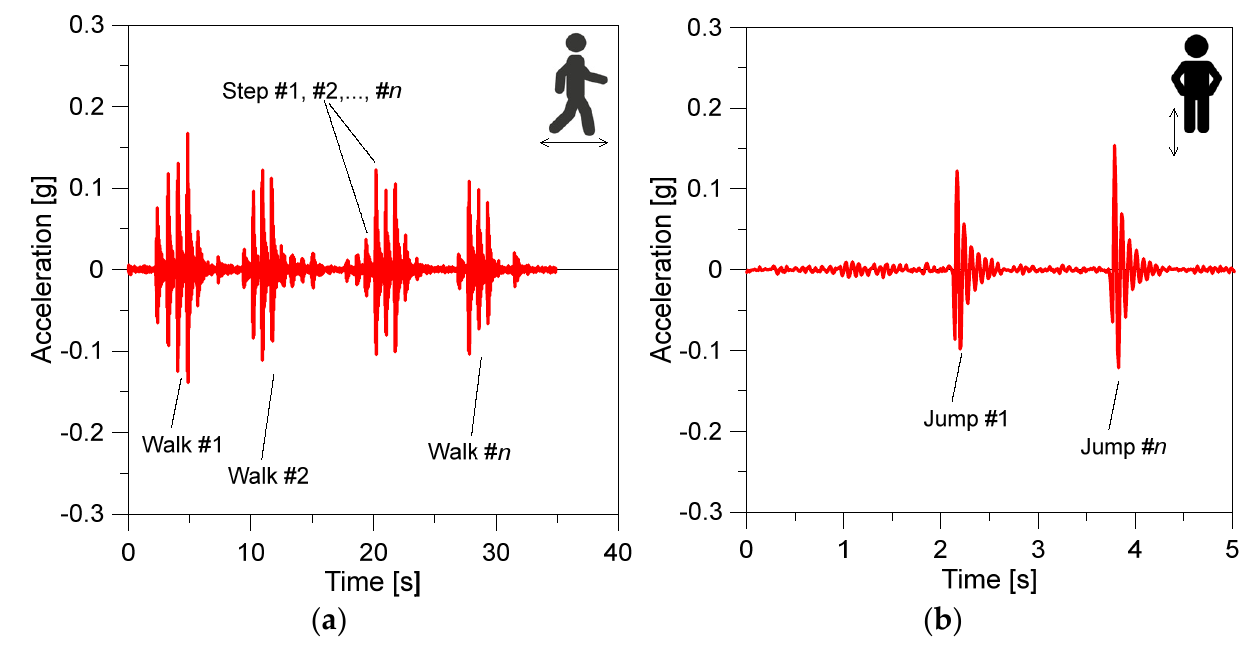
Figure 9. Example of in-field acquisition (selection) of acceleration records (vertical component) un-der ( a ) linear walking path or ( b ) on-site jump.